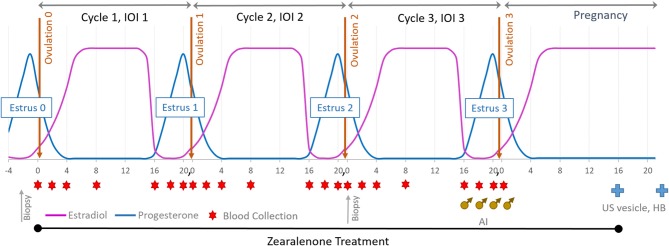
Experimental design: mares were exposed to ZON for three consecutive estrous cycles starting at Day 0 of the first cycle and through to Day 16 after breeding (AI). Blood was collected on Days 0, 2, 4, 8, and 16 and then daily until ovulation. Upon detection of a 32 mm follicle and uterine edema, serum was collected and reproductive activity examined daily until ovulation was confirmed. All mares were artificially inseminated on their 3rd estrus. US was used to determine pregnancy on Day 16 (vesicle) and Heartbeat (HB) on Day 30.